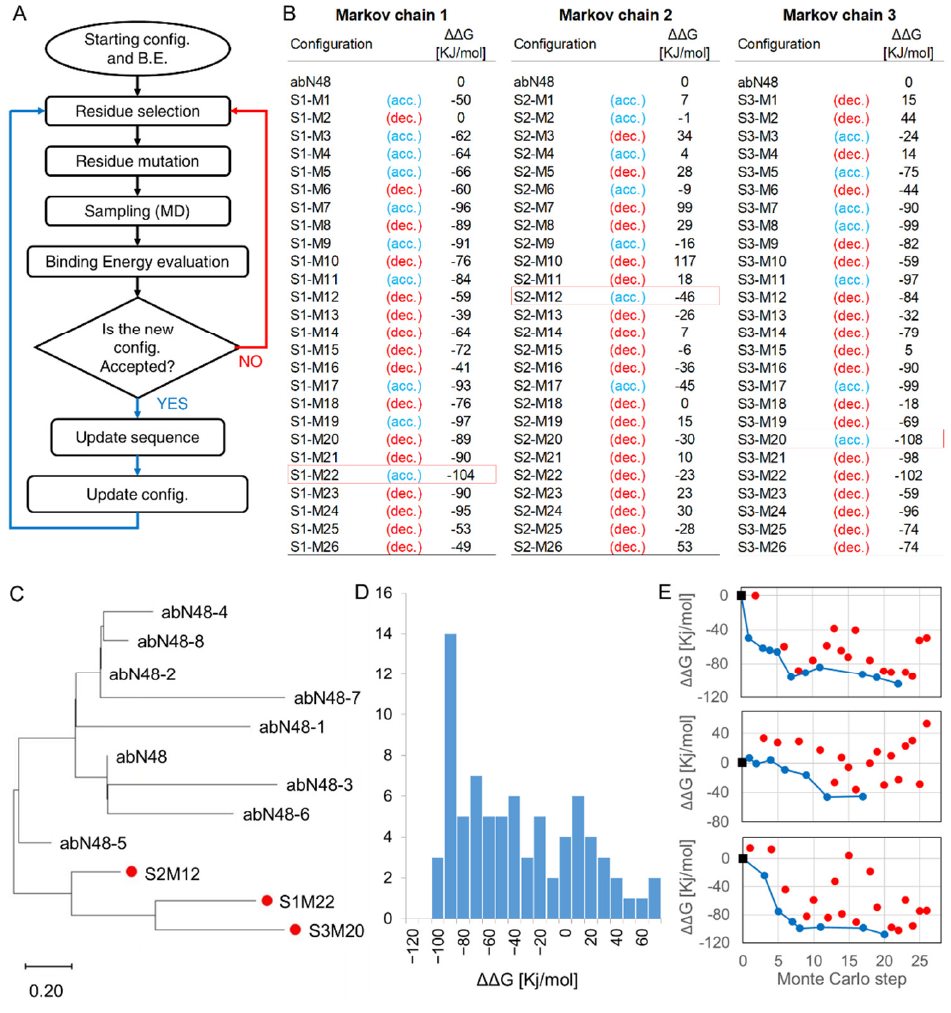
Figure 4. In silico affinity maturation predictions. ( A ) Schematic representation of the Metropolis algorithm. At each step, a new sequence was proposed; if the binding energy of the new configuration was lower than that of the previous one, the new configuration was always accepted; otherwise, the new configuration was accepted with a probability equal to e − ∆∆ G/KT . ( B ) data obtained using the three Markov chain replicas: at each step we indicated whether the mutation was accepted (acc.) or declined (dec.). The best binders for each Markov chain are highlighted with red borders and were selected for experimental validation. ( C ) Maximum likelihood phylogenetic tree constructed using MEGA version 11. The scale bar below indicates the distance (amino acid substitution per site). In silico designed antibodies are represented with red dots. ( D ) Histogram of all the ΔΔGs computed during the three Markov chain repetitions. ( E ) Time course of the energy evaluated during the three different Markov chain repetitions. The starting points are represented with black squares; the en- ergy is shown in blue if the mutation was accepted and in red if it was declined. We ran three replicas of the Markov chain simulation, each starting from the same initial antibody (abN48). Each replica lasted for 26 attempted steps (corresponding to about 10 days of simulations on three different nodes of the computational cluster, a time comparable with that necessary to perform antibody maturation in vitro). Due to the sto- chastic nature of the Monte Carlo method, the replicas produced sequences significantly different from the initial one after the very first step of the Markov chain. In all three cases, the Markov chain rapidly found an antibody sequence with an improved binding energy, despite the starting point already being in the sub-nanomolar affinity (Figure 4B). In most cases, a single point mutation produced an antibody with a binding affinity close to the previous one in the Markov chain. Still, it was also possible to find particularly favorable or unfavorable mutations. The values of ΔΔG of the attempted mutations are skewed